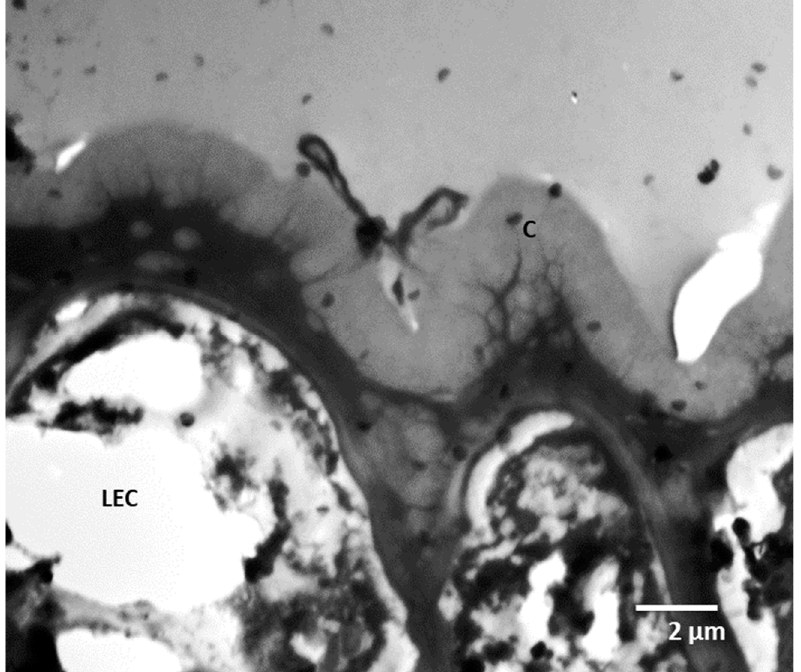
Figure 8. The anatomical modification of the epidermis in the domatia of Rothmannia globose. C: cuticle and LEC: lower epidermal cell.